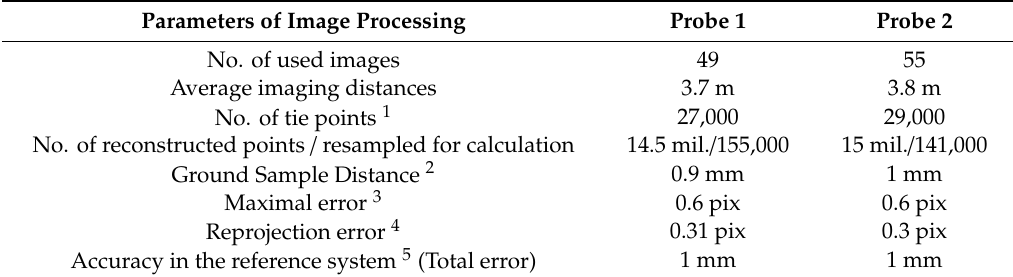
Table 4. Statistical parameters of photogrammetric imaging and SfM